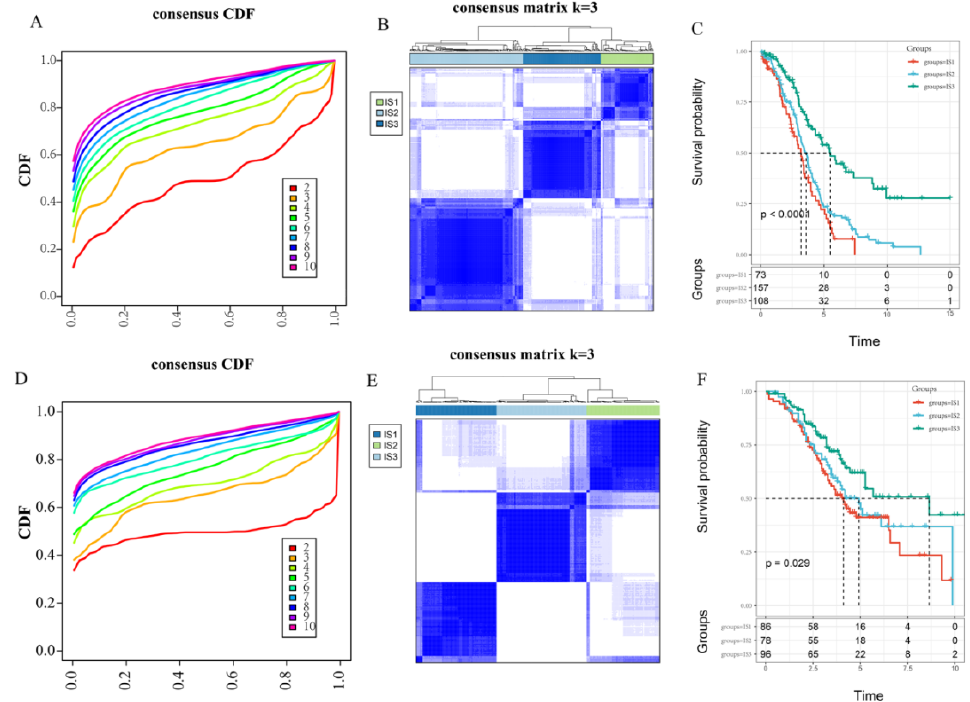
Figure 1. Identification and validation of immune subtypes. ( A ). CDF curve for the TCGA cohort. ( B ). Sample clustering heatmap for the TCGA cohort. ( C ). KM curves showing the OS of the OC immune subtypes in the TCGA cohort. ( D ). CDF curve for the GSE32062 cohort. ( E ). Sample clus ‐ tering heatmap for the GSE32062 cohort. ( F ). KM curves showing the OS of the OC immune sub ‐ types in the GSE32062 cohort.